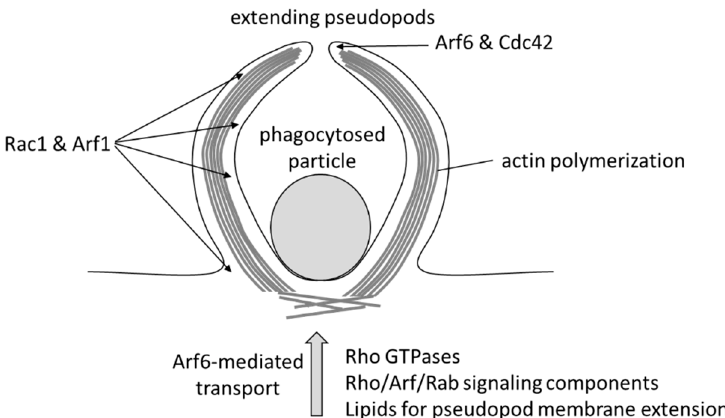
Figure 4. Arf6 in the phagocytic cup: Arf6 and Cdc42 are activated in an early stage of phagocytosis at the tips of the extending pseudopods. Rac1 and Arf1 show a broader distribution along the pseudopods. Arf6 is also responsible for the transport of vesicles to the phagosome.